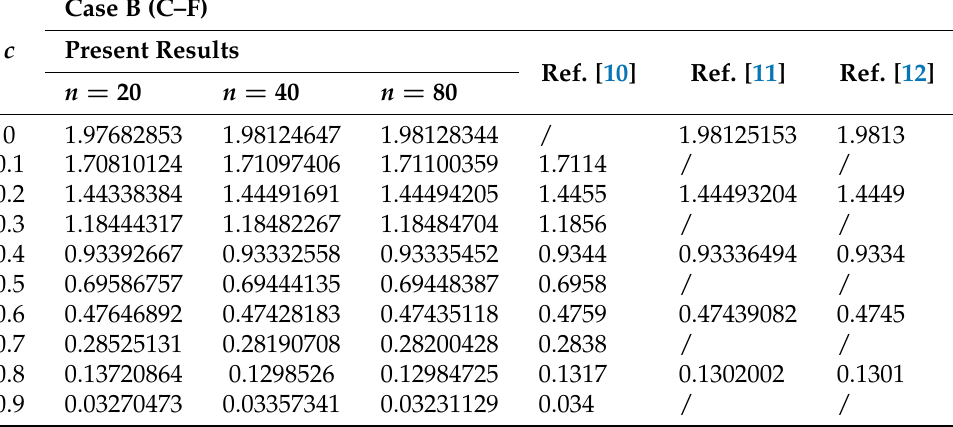
Table 4. Dimensionless critical load of a C–F axially FG Timoshenko beam with different taper coefficient ( m =